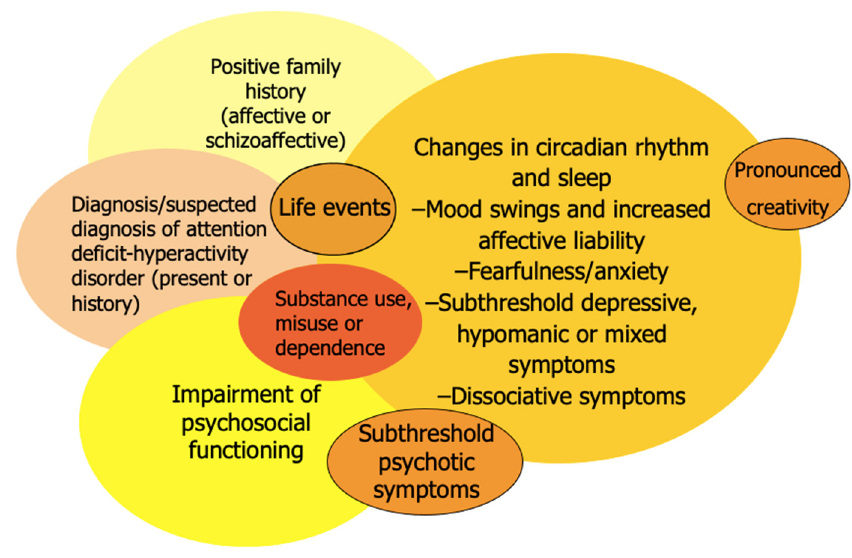
Figure 1. Risk constellations for bipolar disorders.